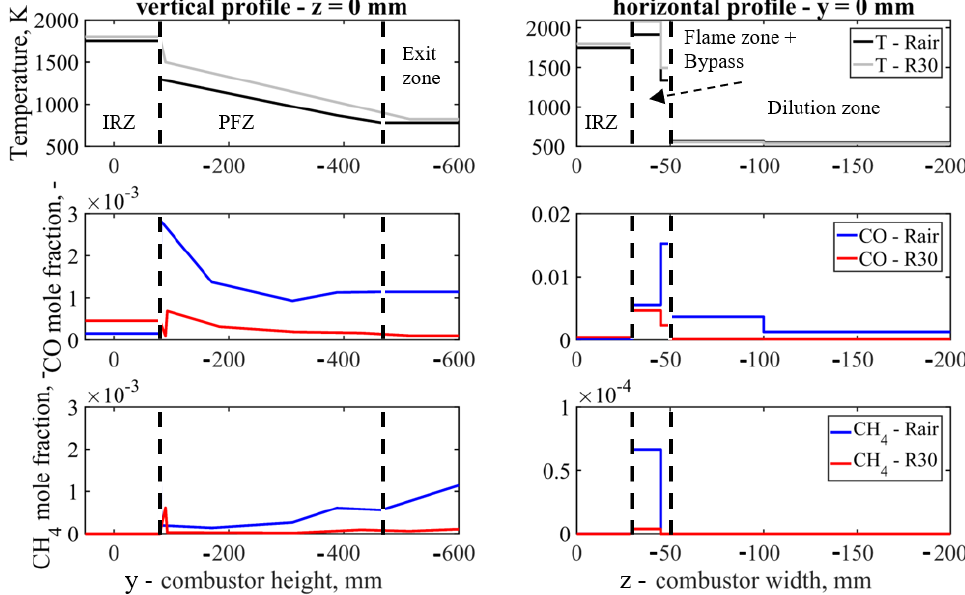
Figure 9. Impact of the oxidizer on CRN species formation and temperatures. Upper row: temperature; middle row: CO mole fraction; lower row: CH 4 mole fraction. The CRN zones are highlighted.